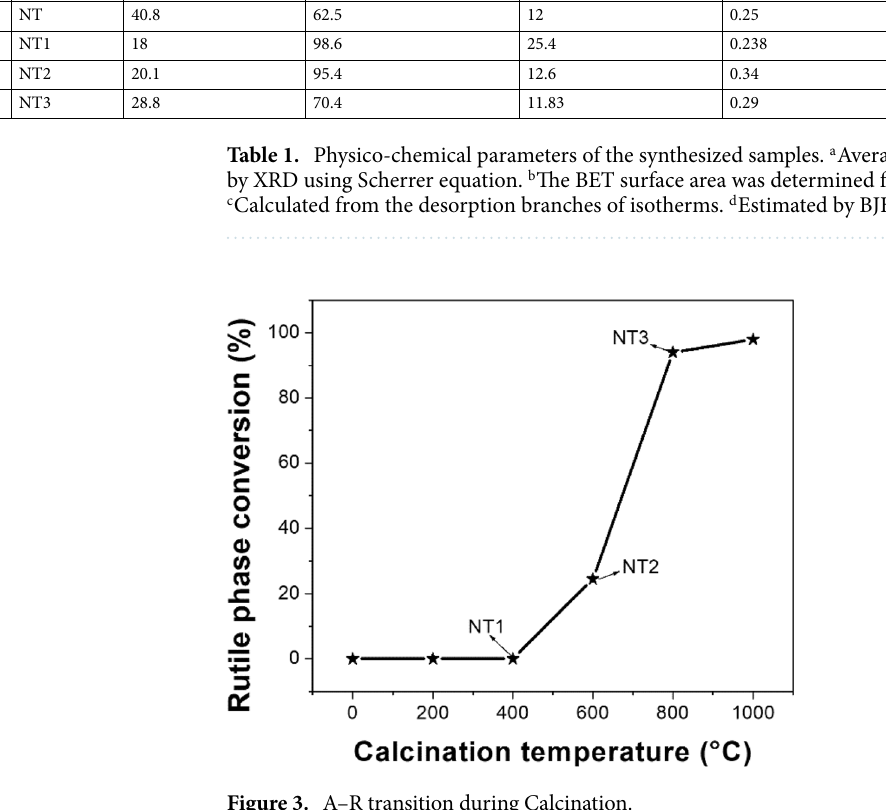
Figure 3. A–R transition during Calcination.